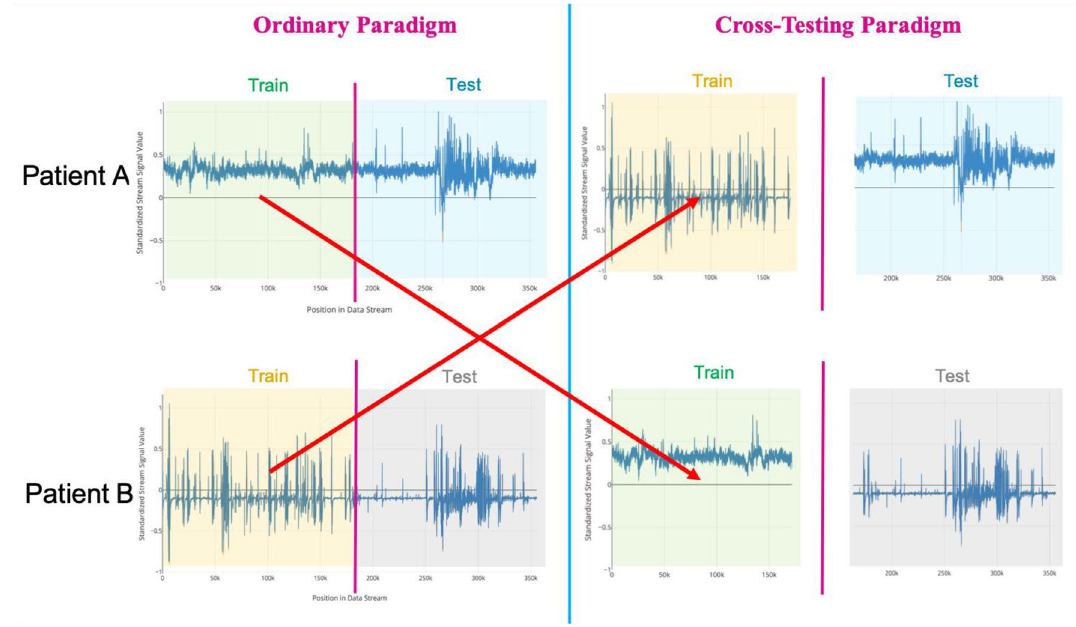
Figure 2. Design of crossover experiments to assess patient-specificity of models. LSTM models were trained on recordings from one patient and tested on recordings from another patient.